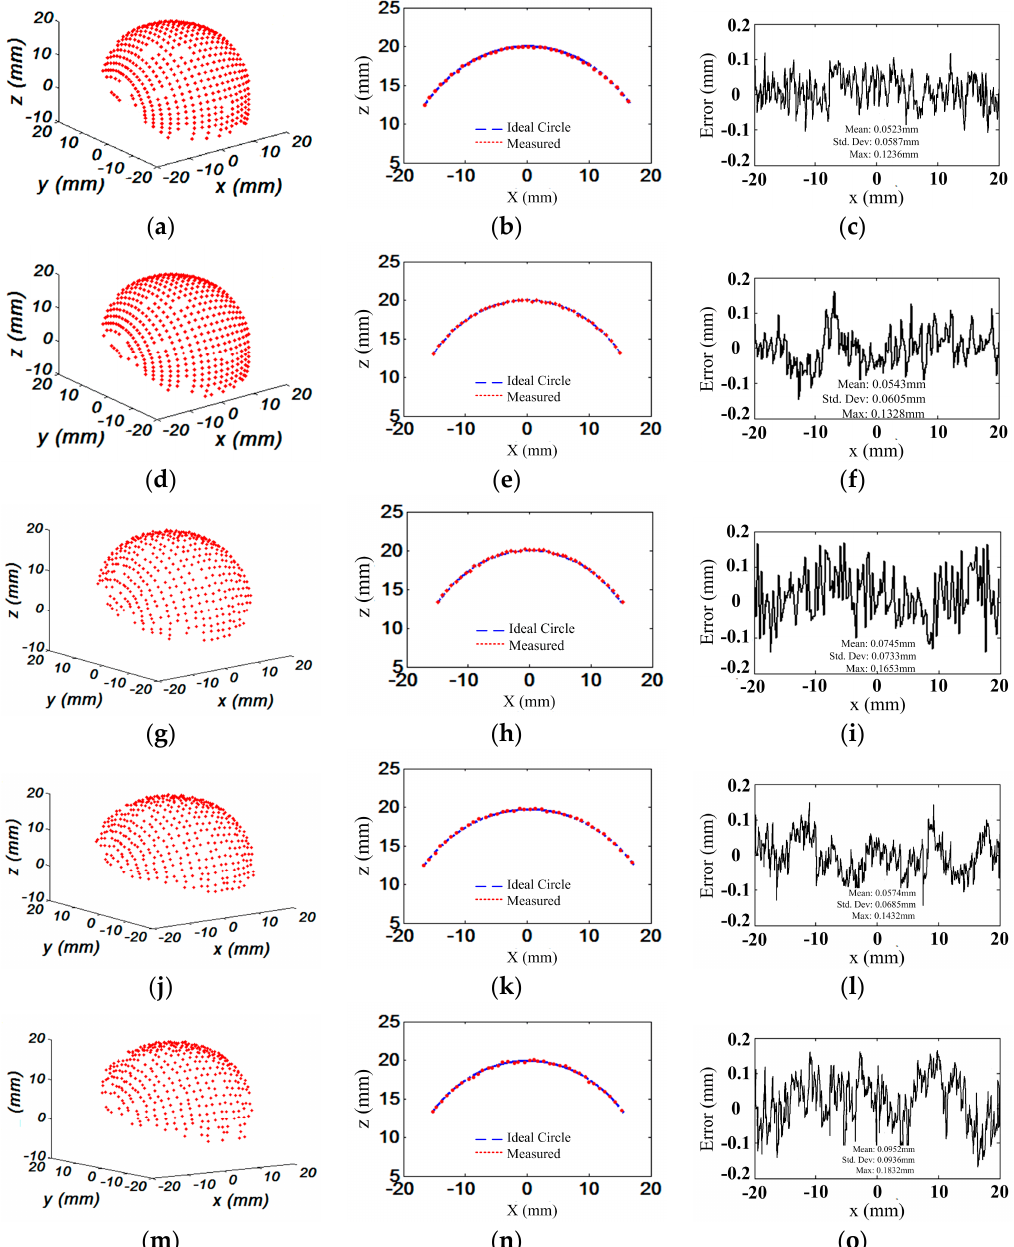
Figure 20. Measurement results and error of a hemisphere surface under different defocusing degrees: ( a ) fitting hemisphere measured under defocusing degree 1 (projector in focus); ( b ) cross section of the measurement result and the ideal circle; ( c ) error estimated in x direction; ( d – f ) and ( j – l ) correspond to figures ( a – c ) measured using our proposed calibration method under defocusing degrees 2 and 5; and, ( g – i ) and ( m – o ) correspond to figures ( a – c ) measured using the calibration method in [29] under defocusing degrees 2 and 5.